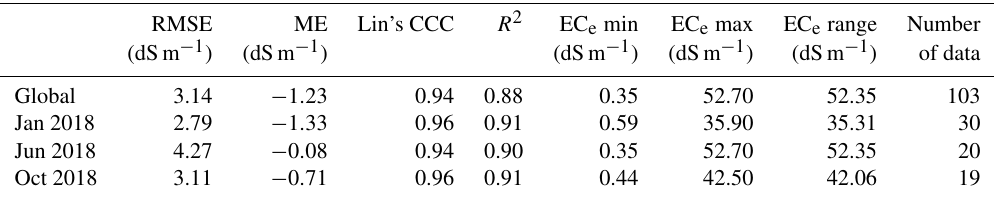
Figure 3. Volumetric water content ( θ – m 3 m − 3 ) and electrical conductivity of the soil saturation extract (EC e – dSm − 1 ) in the topsoil (0–0.3m), subsurface (0.3–0.6m), upper subsoil (0.6–0.9m), intermediate subsoil (0.9–1.2m), and lower subsoil (1.2–1.5m), measured in the sampling site located at the middle of each transect, at locations 1 to 4, during the study period. Each circled number refers to each location. Crosses refer to the dates when there were EC e measurements but no σ measurements, due to adverse field conditions. Table 2. RMSE, ME, Lin’s CCC, R 2 , minimum, maximum, and range of EC e , and the number of data used to calculate these statistical indicators, discriminated in terms of global and date of